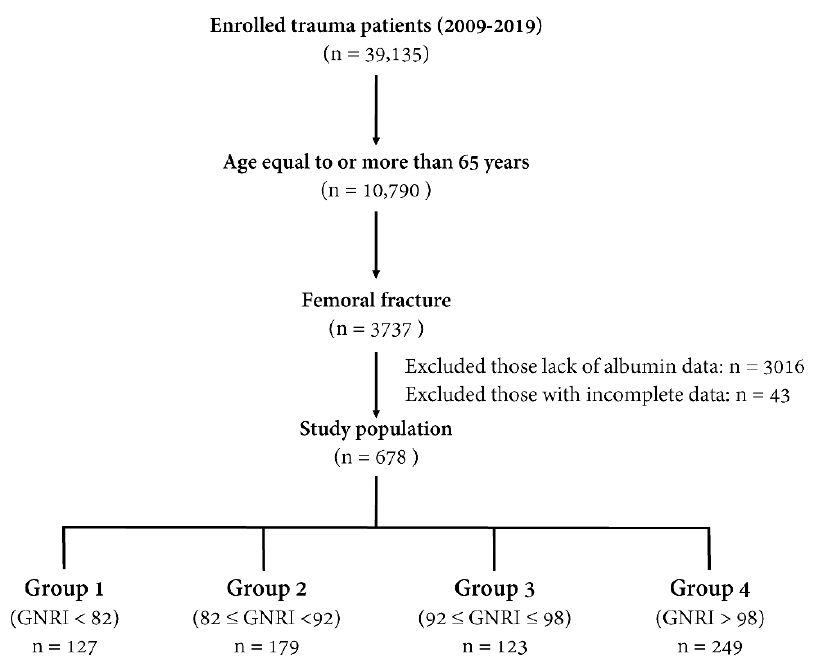
Figure 1. A flow chart illustrating the inclusion of elderly patients who had undergone trauma with femoral fractures, with the allocation of these patients into four nutritional risk groups.